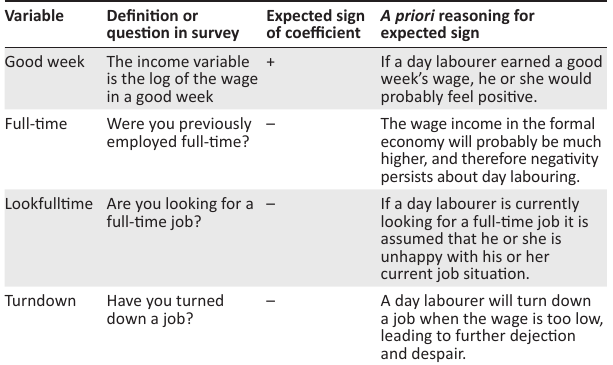
TABLE 9: Economic variables.